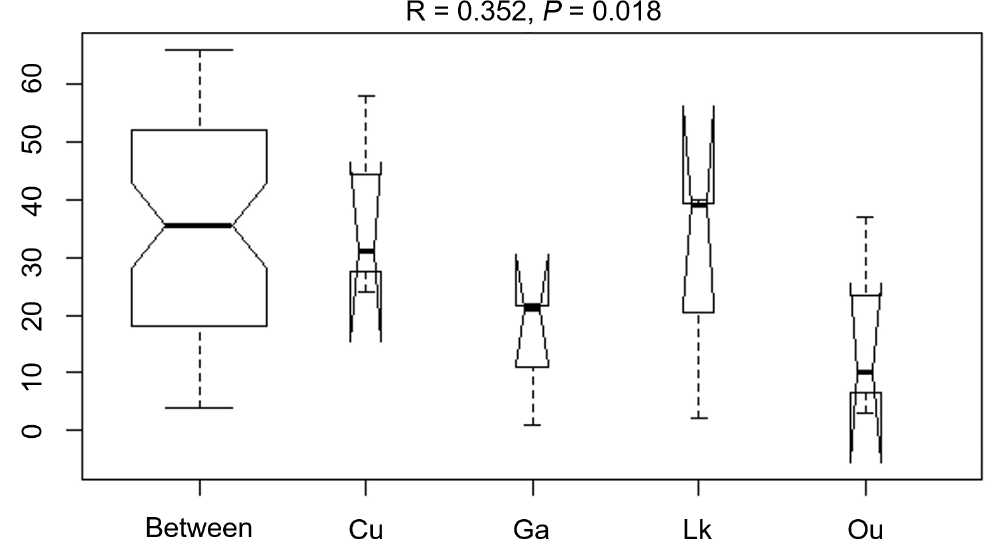
Figure 7. ANOSIM comparison (R statistics) of the four coral reef fishes from the South China Sea. Ou: O. unifasciatus , Cu: C. urodeta , Lk: L. kasmira , Ga: G. aurolineatus. Table 2. Unique gut microbial community at genus level in four different coral reef fishes from the South China Sea.